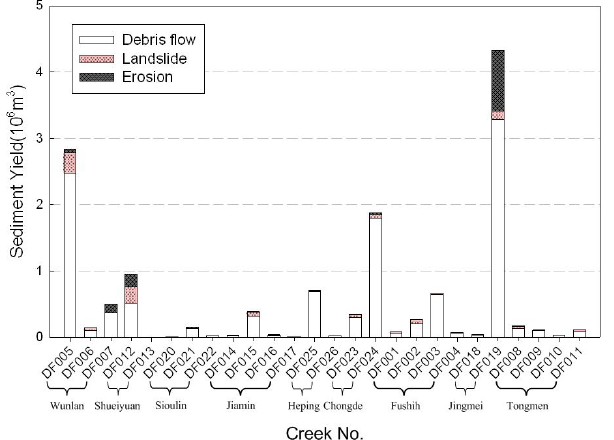
Figure 8. Sediment yields supplied from three different sediment sources in each potential debris-flow watershed.